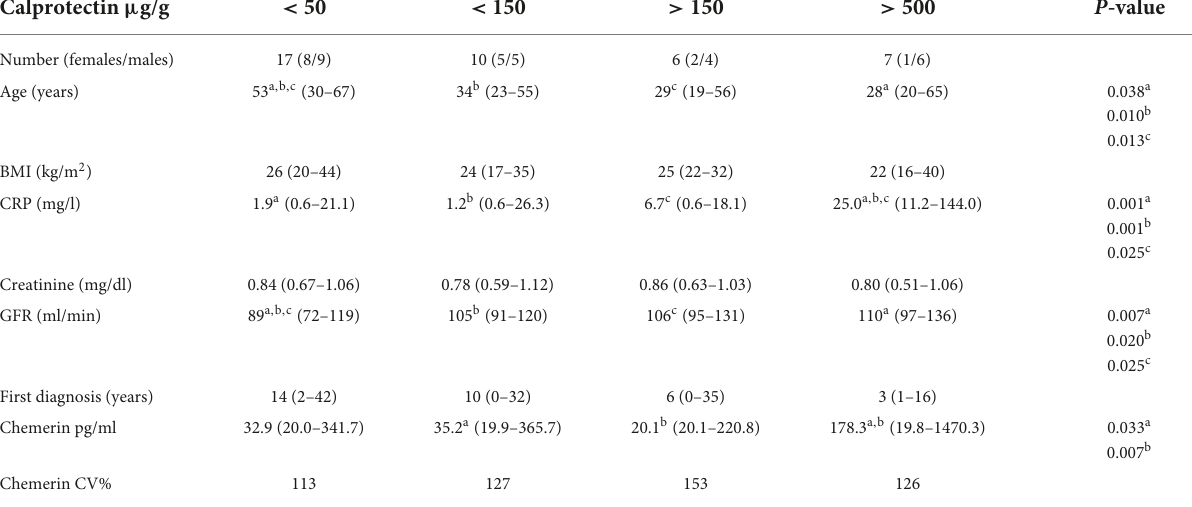
TABLE 2 Characteristics of the patients stratified for fecal calprotectin